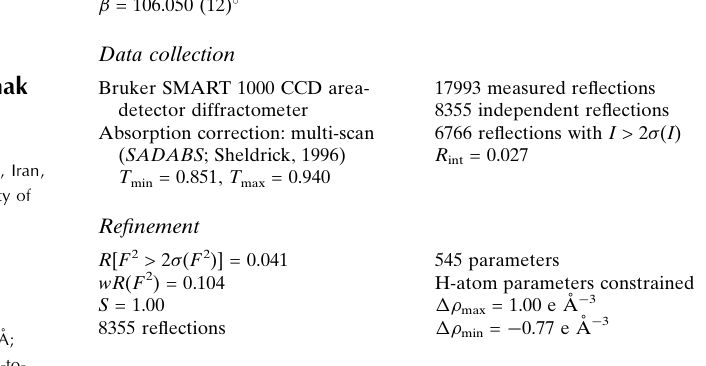
parameter ratio = 15.3.